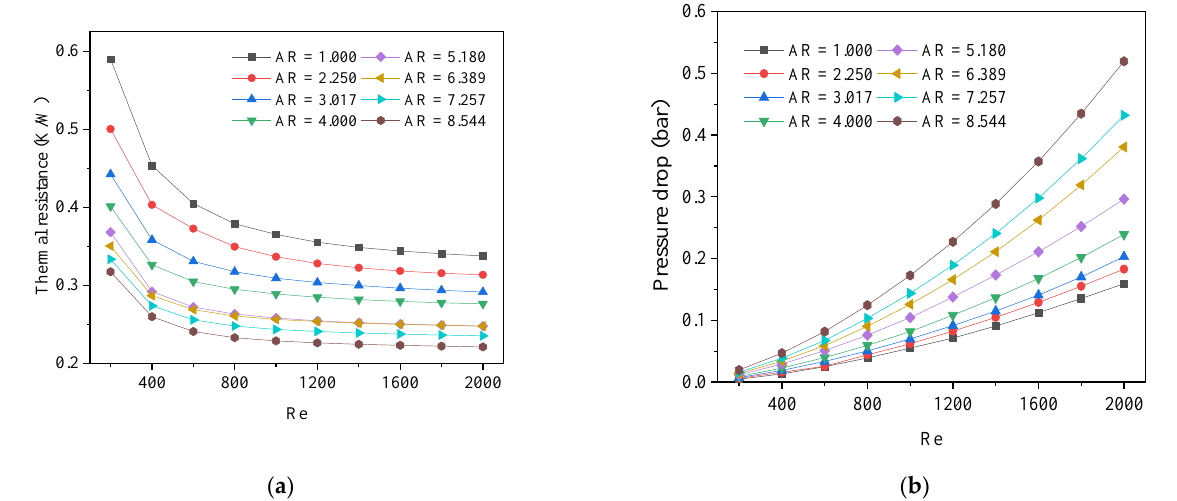
Figure 4. The variation of thermal resistance ( a ) and pressure drop ( b ) for different Reynolds numbers with aspect ratios ranging from 1.000 to 8.544. The fluid in the boundary layer had a relatively low flow velocity, resulting in a high fluid temperature and a low temperature gradient, which reduced the intensity of the heat transfer [37]. As shown in Figure 5a, in the same Reynolds number condition, the increase in the aspect ratio indicates the thinning of the boundary layer. In particu- lar, the change of the aspect ratio had a greater impact on the low flow rate region at the corner of the microchannel cross-section and at the bottom of the upper microchannel, which played a key role in the improvement of the heat transfer efficiency. According to Figure 5b, by comparing the microchannel velocity flow diagrams for AR = 1.000 and AR = 7.257 at the same Reynolds number, it could be found that as the microchannel aspect ratio increased, its corresponding low flow velocity region decreased.